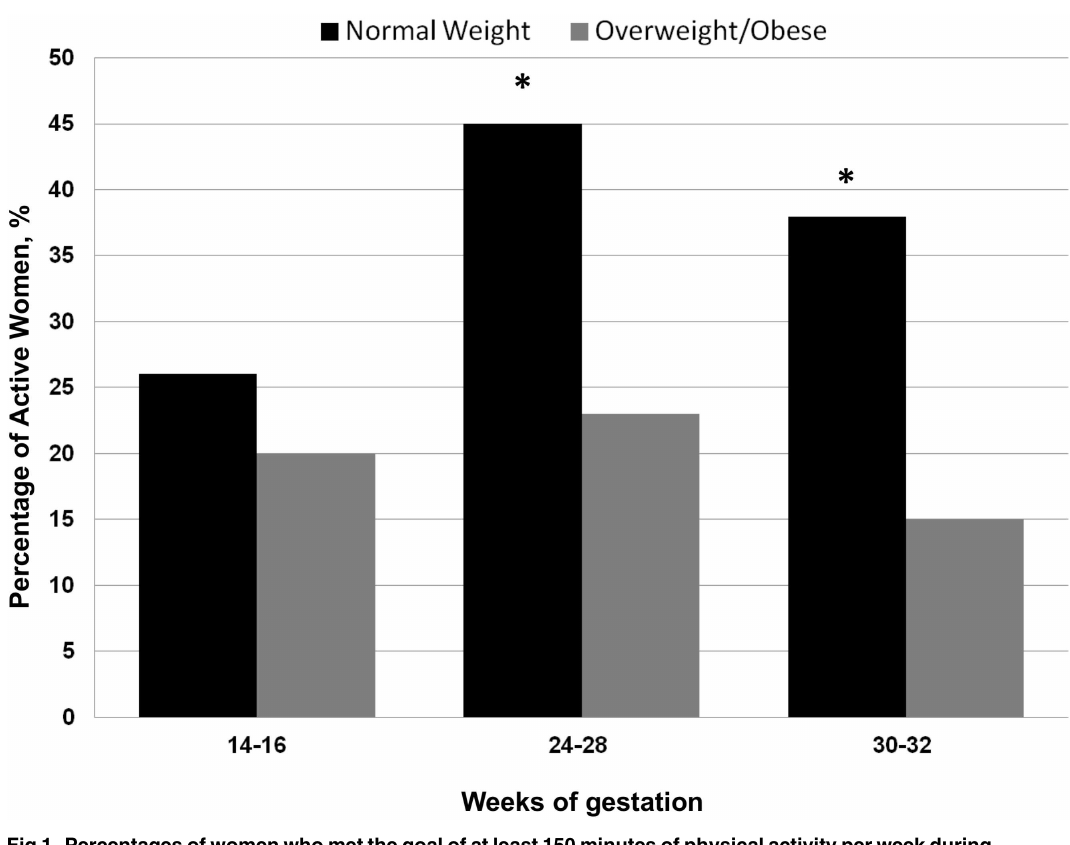
Fig 1. Percentages of women who met the goal of at least 150 minutes of physical activity per week during pregnancy in normal-weight and overweight/obese women, at 14–16, 24–26 and 30–32 weeks of gestation, respectively. * p < 0.05 between normal-weight and overweight/obese women (by the Chi-squaretest).